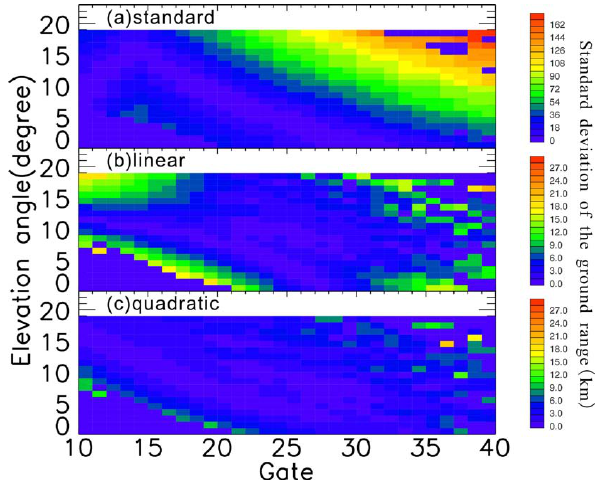
Fig. 10. Height standard deviation of (a) the linear model and (b) quadratic polynomial model determined by gate and elevation angle. The data set of 2009 is